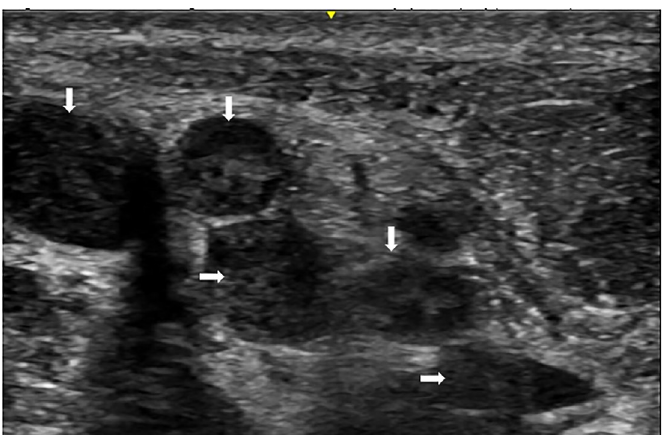
Image 2. Point-of-care ultrasound images with extensive cervical reactive lymphadenopathy (white arrows).